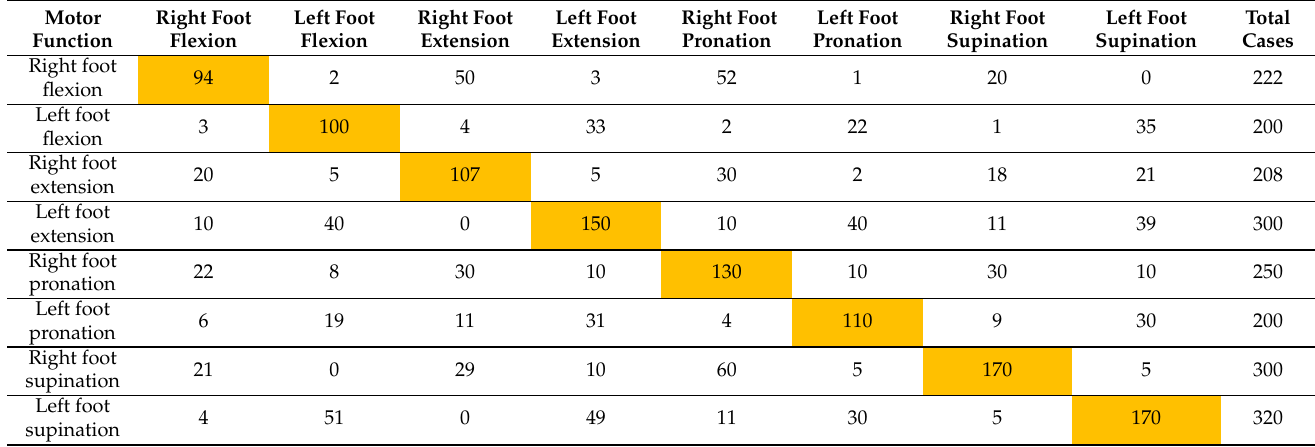
Table 8. Confusion matrix for the proposed DL model without transfer